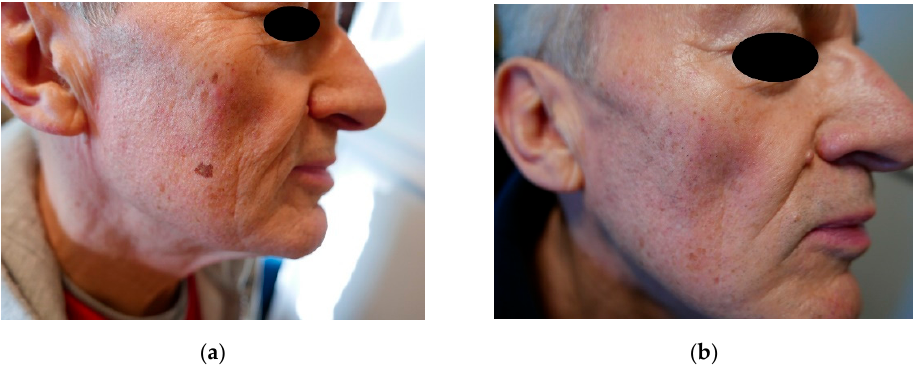
Figure 1. ( a ) Solar lentigines on the face, before treatment, ( b ) solar lentigines on the face, after treatment.